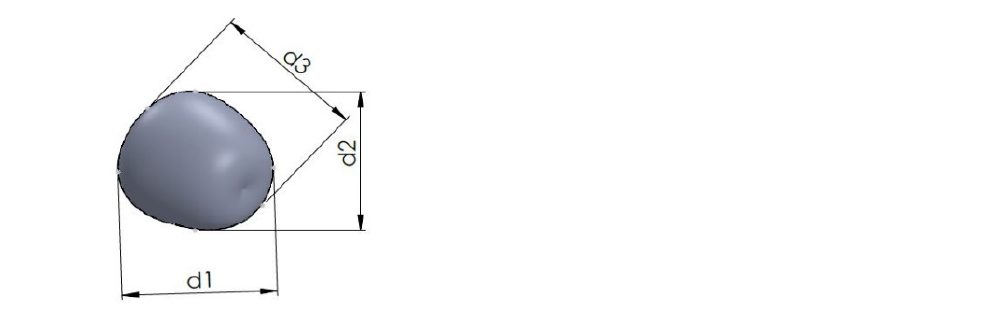
Figure 3. Measuring glass for volume measurement. 2.4. The Mass-to-Volume Dependency of the Fertilizers According to the fertilizer dose Q , the fertilizer is precision-dosed by mass, within the range of Q = 20–60 g per plant. Based on this and the measurement results, the mass- to-volume dependency was determined for the fertilizer. For this purpose, a correspond- ing graph was prepared, which contained approximation functions. 2.5. A Determination and Setting of the Dosing Mass for the Volumetric Dosing Unit A grooved roller doser was chosen as the volumetric doser to be used due to the simplicity of its construction and operation. The granulized fertilizer is metered in terms of the amount of fertilizer that is inside one or more of the grooves in the grooved roller (Figure 4a), according to the fertilizer dosage; therefore, it is important to first determine the groove’s volume V r .